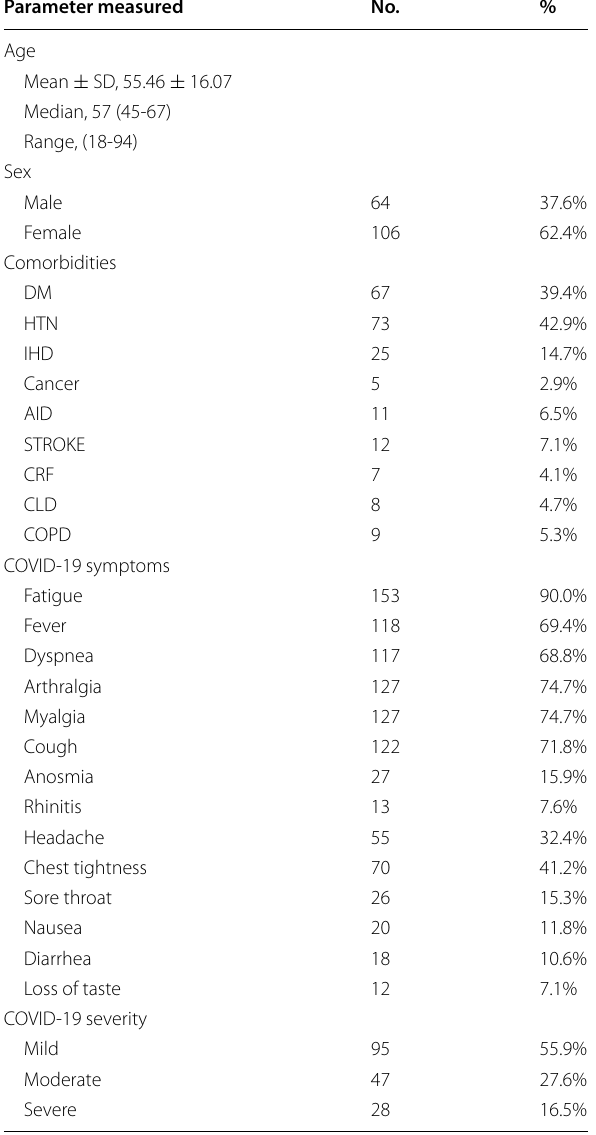
Table 1 Descriptive of demographic data, clinical characteristic, and severity of COVID-19 among our